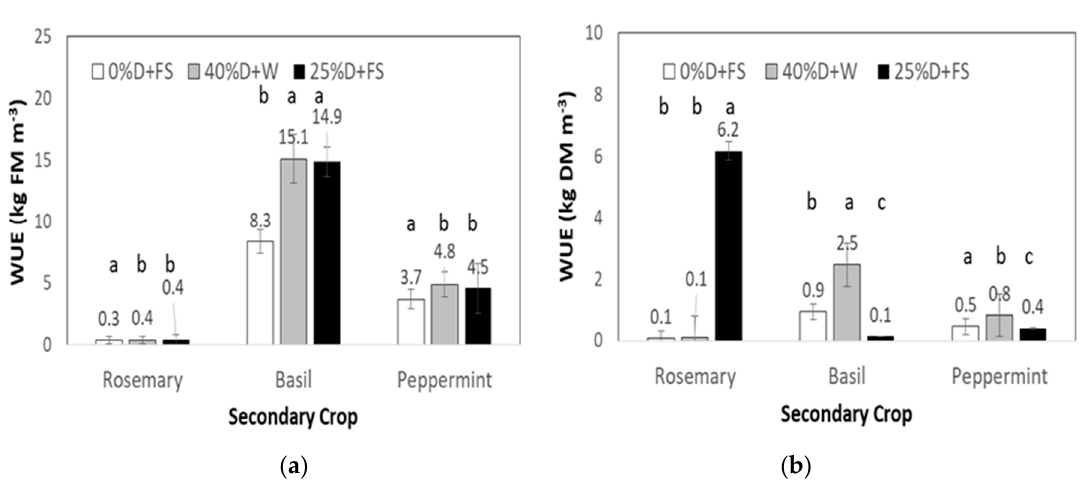
z Di ff erent letters within a row for FM or for DM indicate statistically significant di ff erences ( p < 0.05).